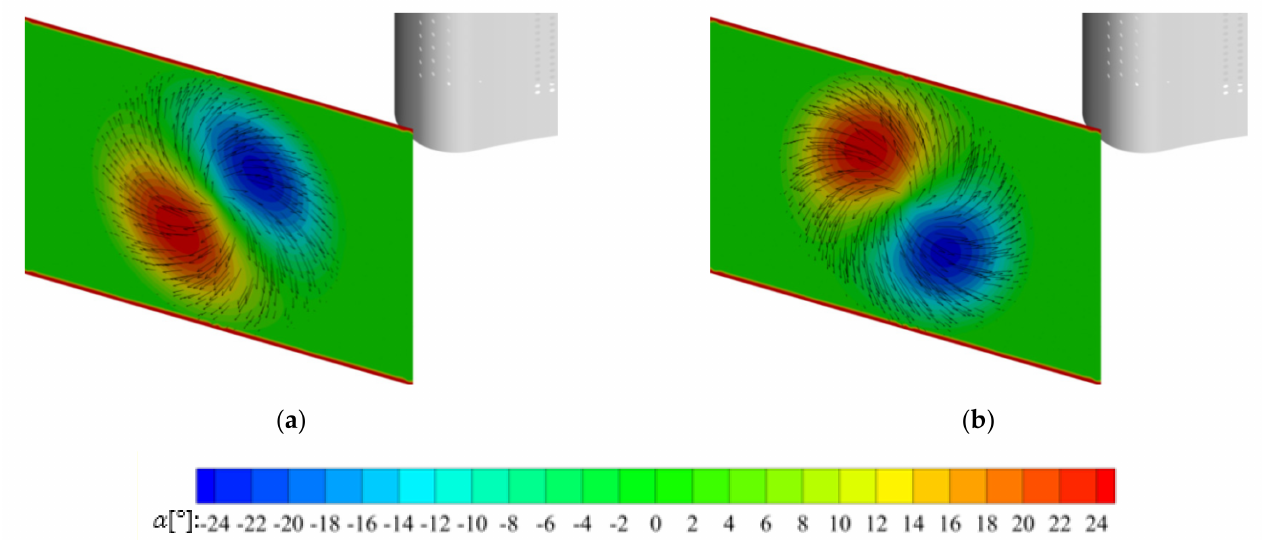
Figure 7. Swirl angle and velocity vectors distribution at the stage inlet plane. ( a ) Case 3: HS and positive swirl; ( b ) Case 4: HS and negative